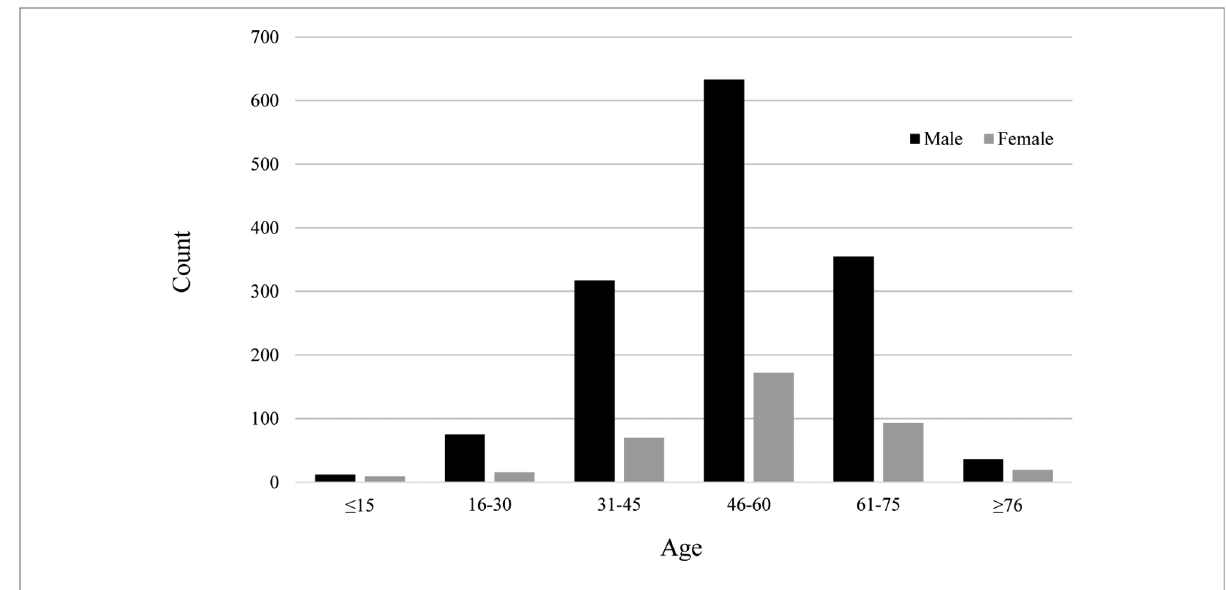
FIGURE 2 High-risk age group of different genders.